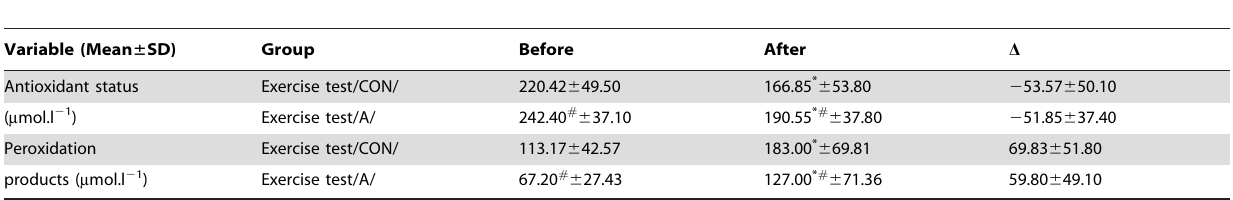
Table 5. Changes in concentration of lipid peroxidation products and antioxidant status in blood plasma in CON and A subjects during exercise